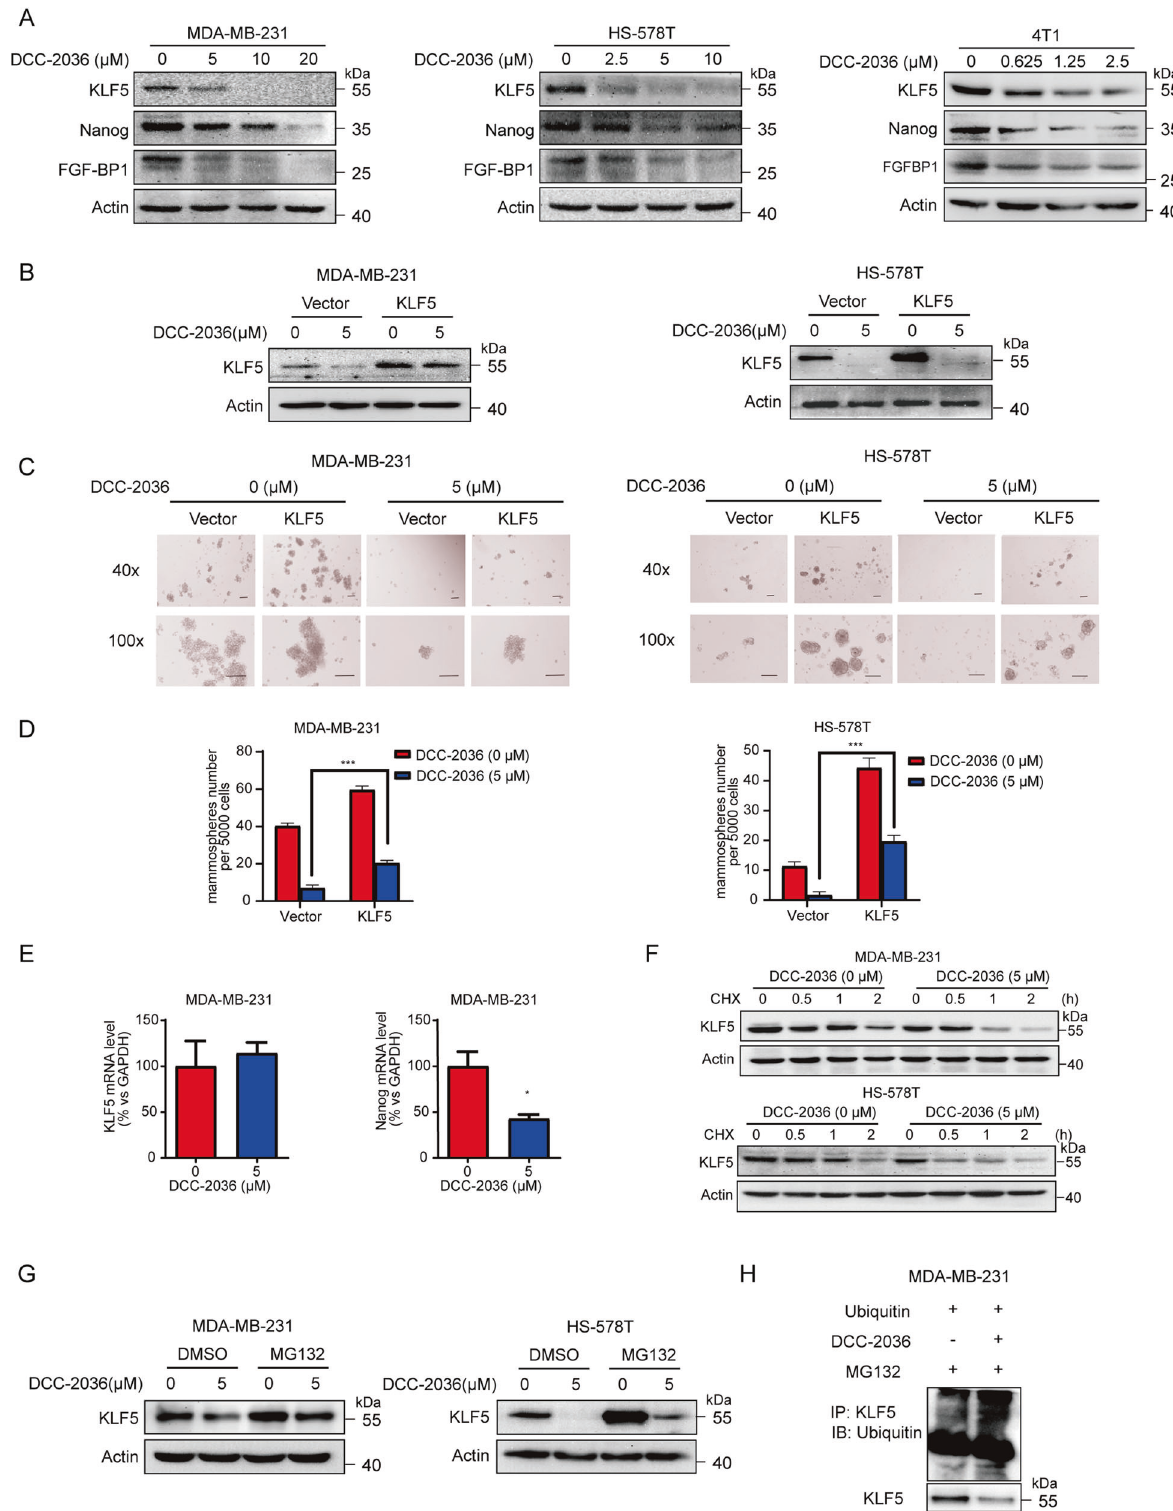
The following antibodies were used for immunohistochemical staining at the indicated dilution: human and murine KLF5 (Proteintech;